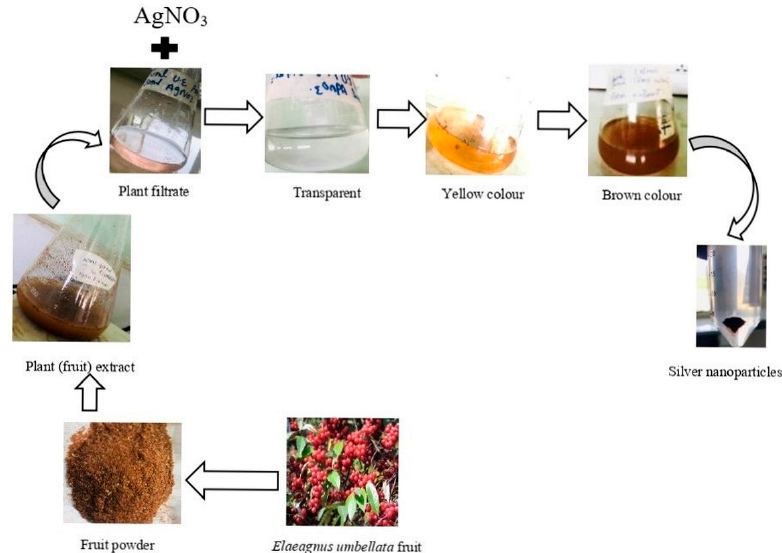
Figure 1. Synthesis of silver nanoparticles using Elaeagnus umbellata fruit extract.